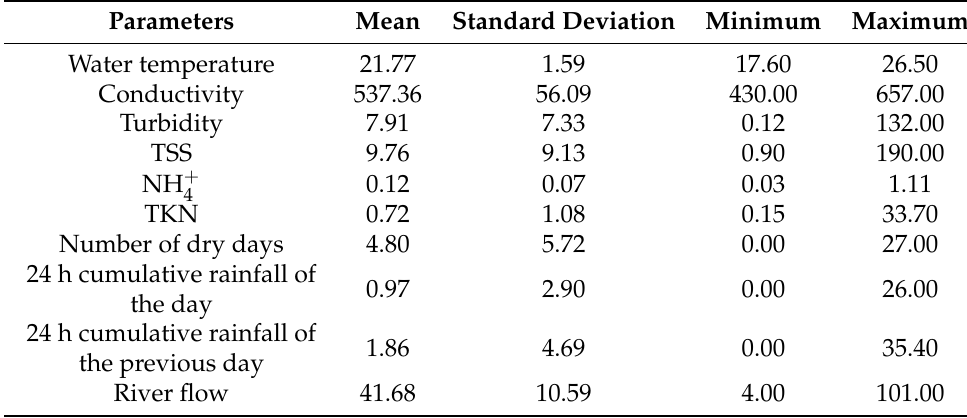
Table A1. Descriptive statistics of the